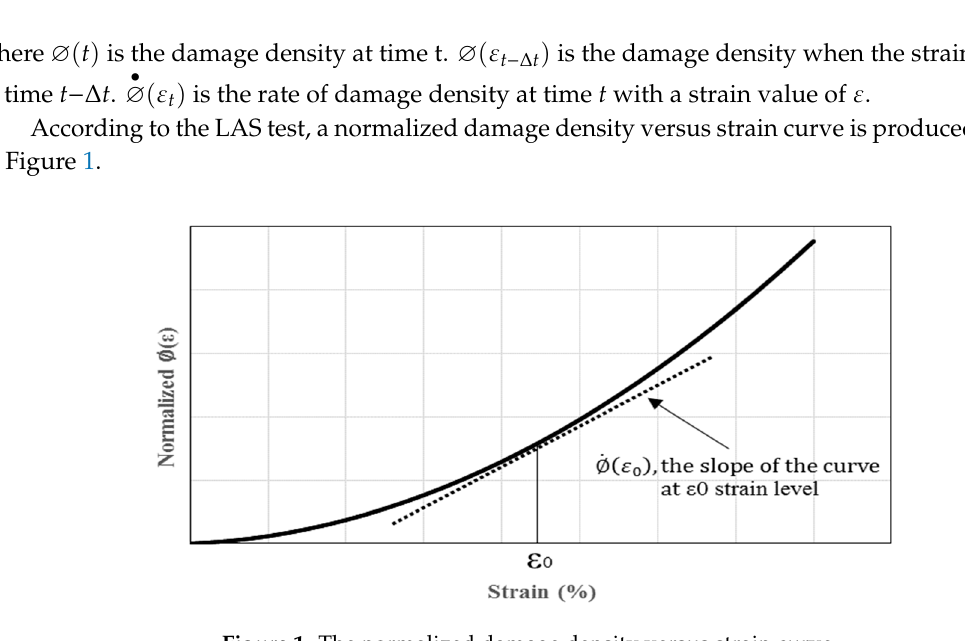
Figure 1. The normalized damage density versus strain curve.